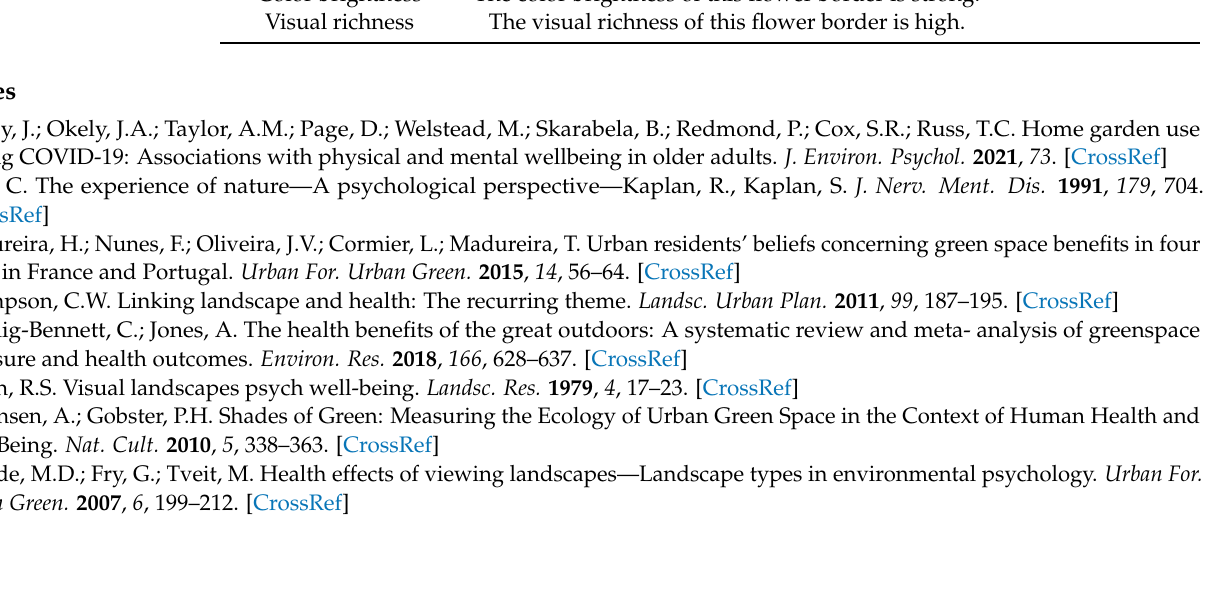
Table A1. Questionnaire 1. Aesthetic preference and categorical visual attributes scale for the flower borders (Imagine you are in the scene presented by the image, how would you agree with the √ description; please tick the images with ‘ ’ in your selected items). Variable Aesthetic preference This vegetation landscape is very beautiful. Color contrast The color contrast of this flower border is strong. Color brightness The color brightness of this flower border is strong. Visual richness The visual richness of this flower border is